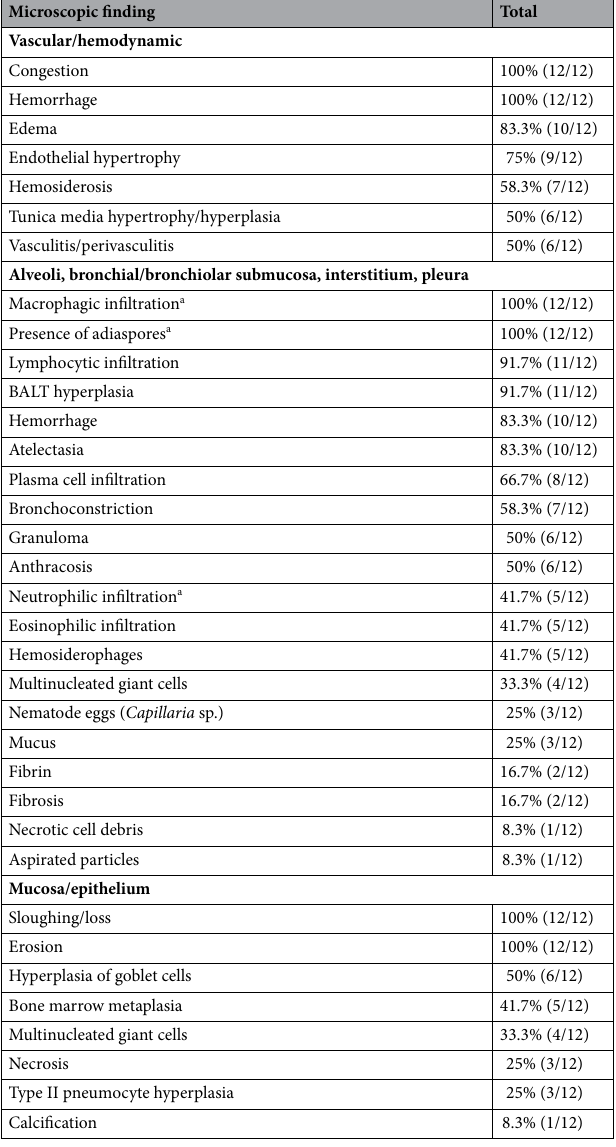
Table 3. Microscopic pulmonary findings in armadillos with pulmonary adiaspiromycosis died by motor vehicle collisions in Brazil, 2017–2020. a Findings associated with PA. BALT bronchi- and bronchiole-associated lymphoid